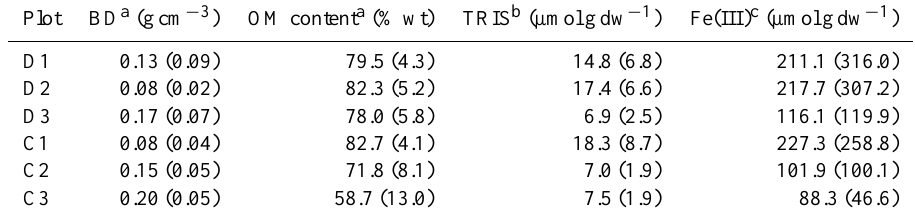
Table 1. Bulk density (BD), organic matter (OM), solid phase contents of total reduced inorganic sulfur (TRIS) and reactive ferric iron Fe(III) among the investigated plots. All values are means (and SD) from 30cm peat profiles (Estop-Aragon´es et al., 2012; Knorr et al., 2009). Note the comparatively high BD, low OM and low TRIS and Fe(III) in D3, C2 and C3. The TRIS and Fe(III) content were not monitored during the periods evaluated in this study and are only shown in this table (and figures) to emphasise the differences among plots. Plot BD a (gcm − 3 ) OM content a (% wt) TRIS b (µmolgdw − 1